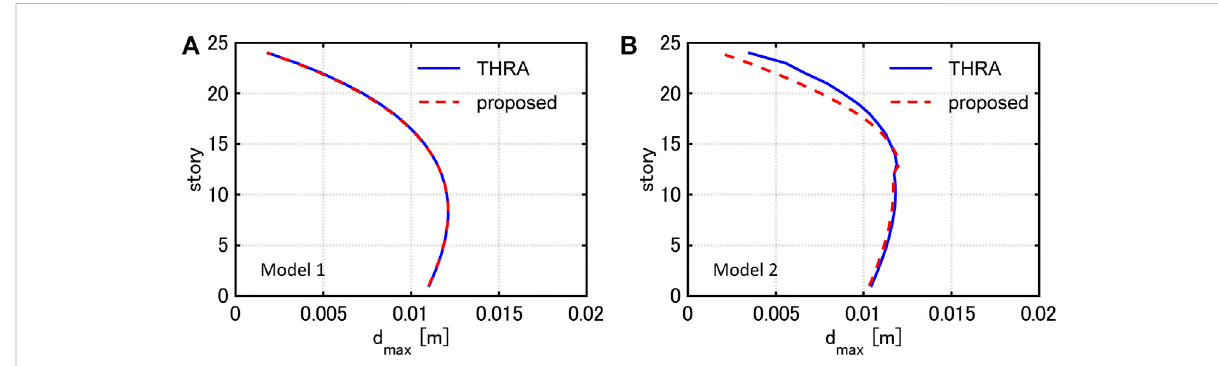
FIGURE 3 Maximum interstory drifts under PSI with V (cid:1) 0 . 5m / s by time-history response analysis and proposed method, (A) Model 1, (B) Model 2.